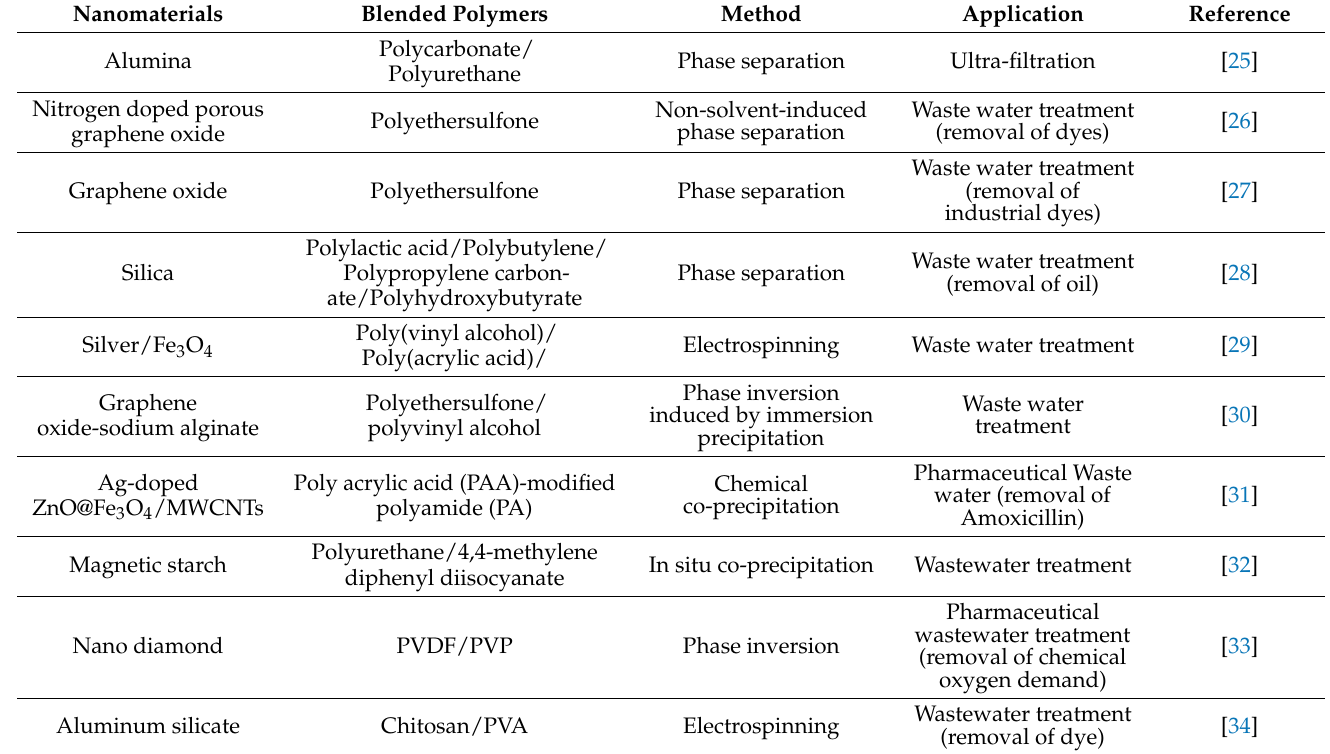
Table 1. Application of blended polymer